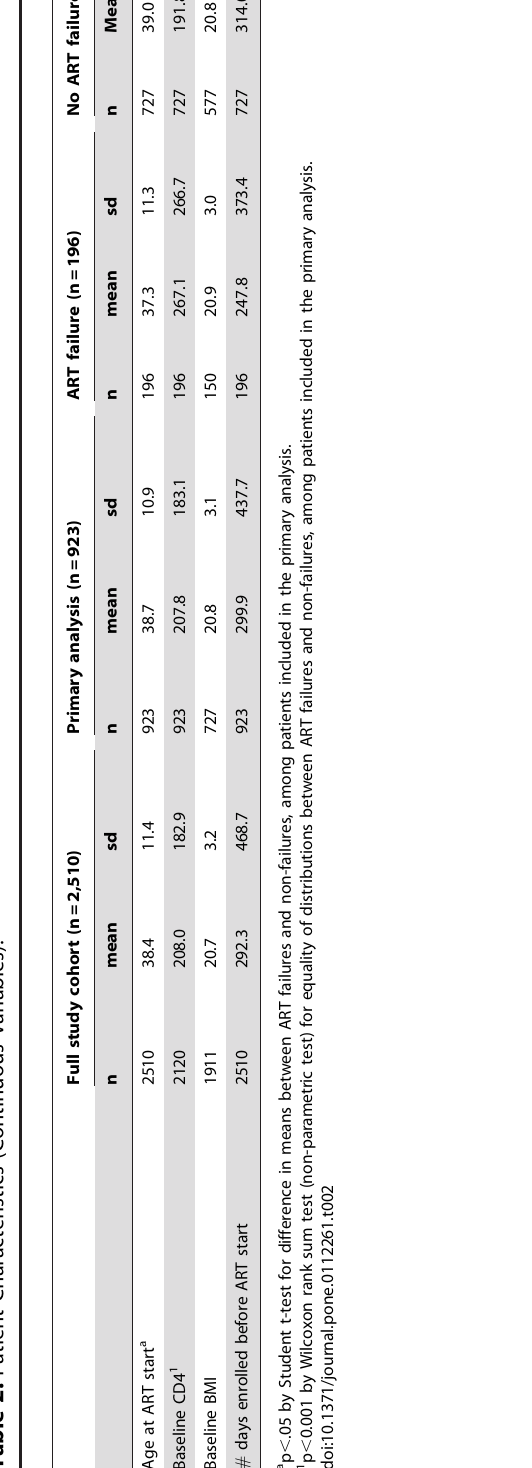
Table 6 . The implications of applying each risk test strategy to a hypothetical population of 1,000 patients, with and without resource constraints for actually targeting those with a positive